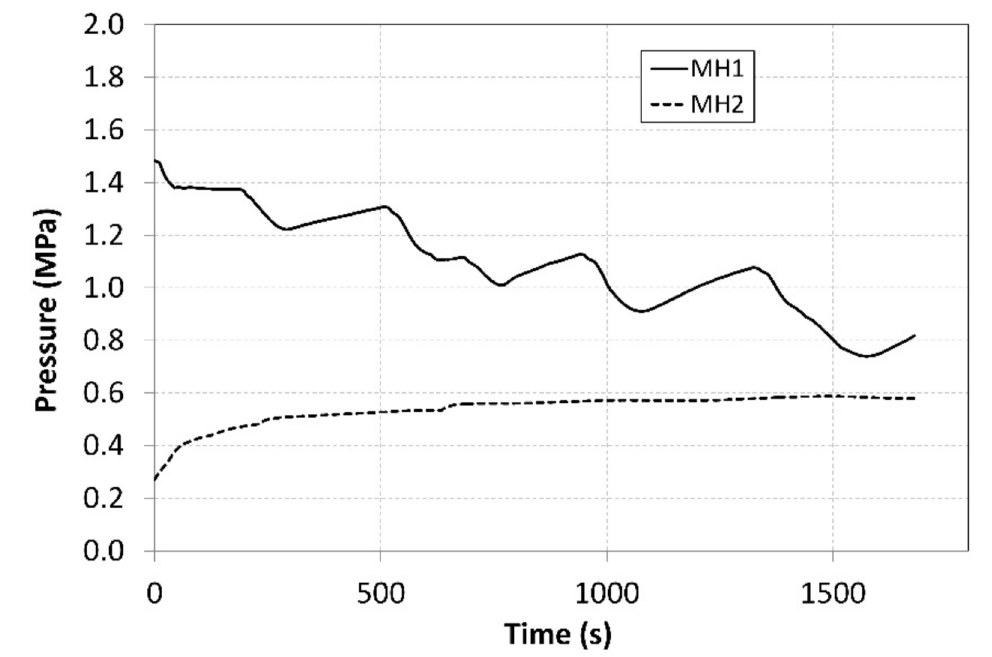
Figure 9. Curves of relative pressures in MH1 and MH2 tanks.